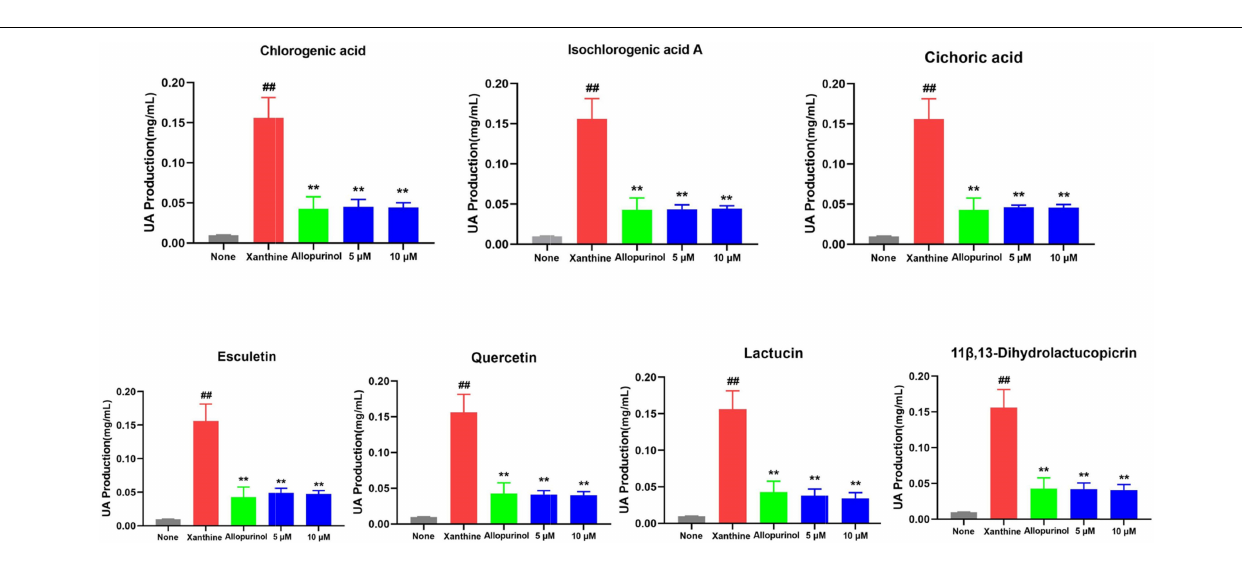
FIGURE 11 | Seven compounds were able to significantly reduce uric acid production and their activity was comparable to that of allopurinol ( p < 0.01, 5 µ M, and 10 µ M). The uric acid(UA)-lowering efficacy of seven compounds from chicory in L02 cells administered with xanthine. ## p < 0.01 vs None group; ** p < 0.01 vs Xanthine group. n = 3, mean ±